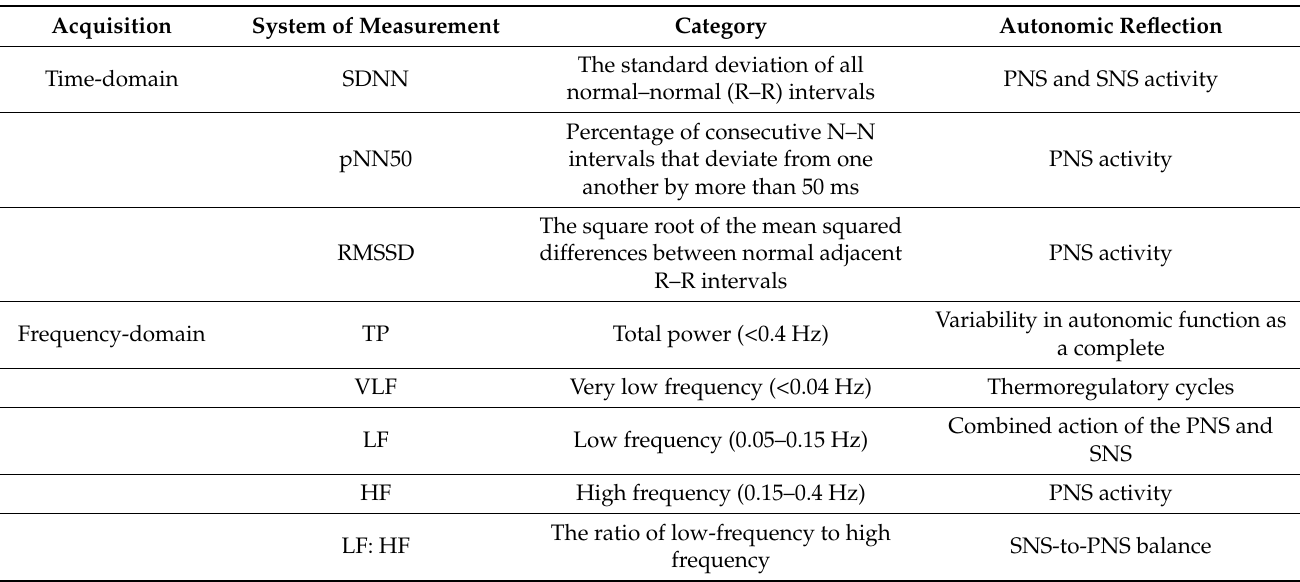
Table 1. Heart rate variability and their equivalent representation of the autonomic nervous